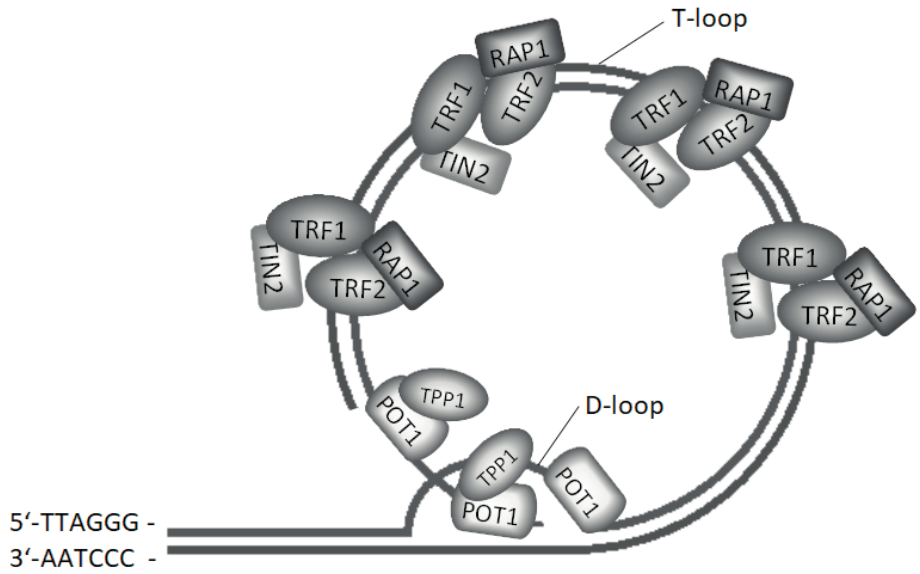
Fig. 1. A chromosomal end with telomeric repeats forming shelterin complex with T-loop that binds telomeric repeat binding factors 1 and 2 (TRF1 and TRF2), TRF1-interacting nuclear protein 2 (TIN2), human repressor activator protein 1 (RAP1) and single-stranded D-loop on 3’-overhang binding protection of telomeres 1 (POT1) and tripeptidyl peptidase 1